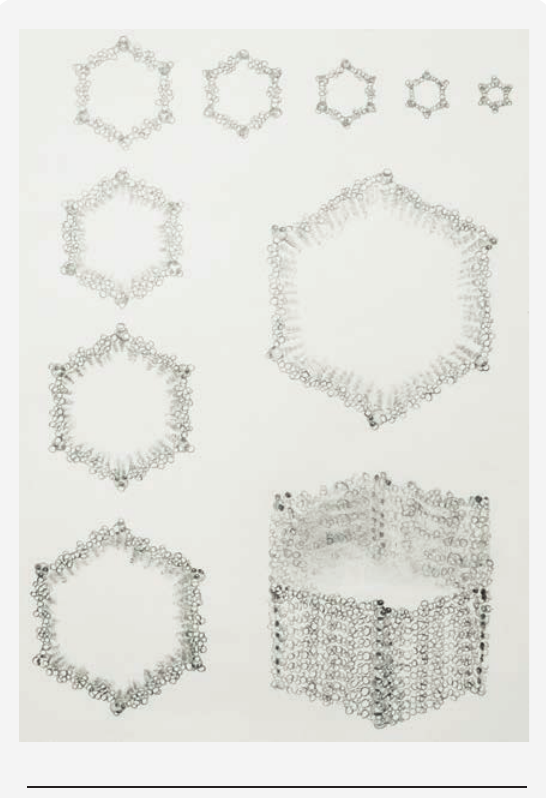
Fig. 3b. Isoreticular series of MOF-74 showing progressively larger pore opening.